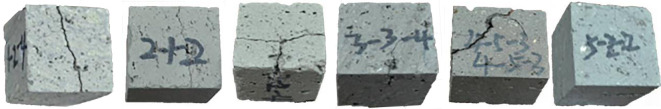
Photographs of six damaged samples after 10 freeze–thaw cycles. The failure modes caused by freeze–thaw cycles are mainly macrocracking.